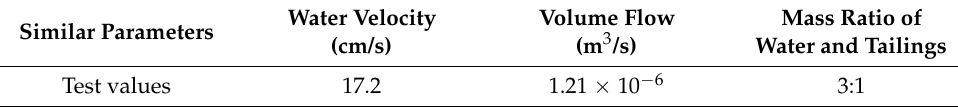
Table 4. The hydraulic parameters of the physical model.